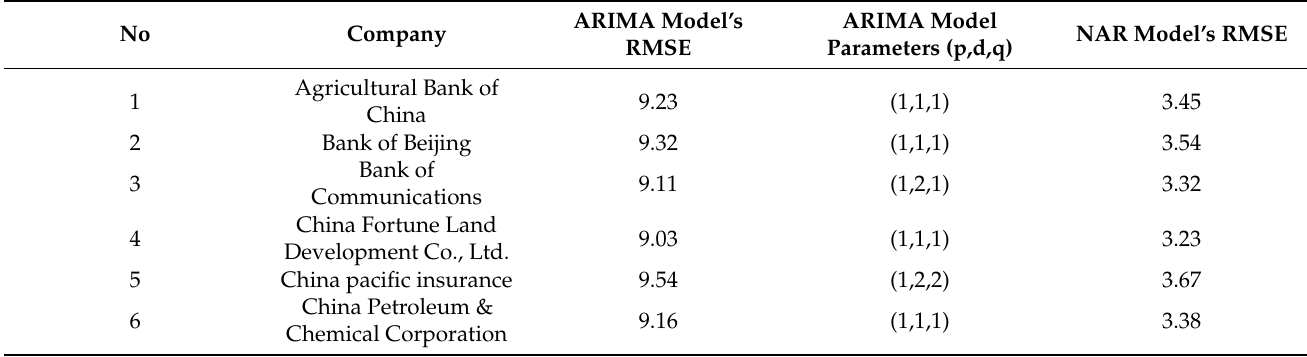
Table 3. RMSE metric of ARIMA and NAR models for 6